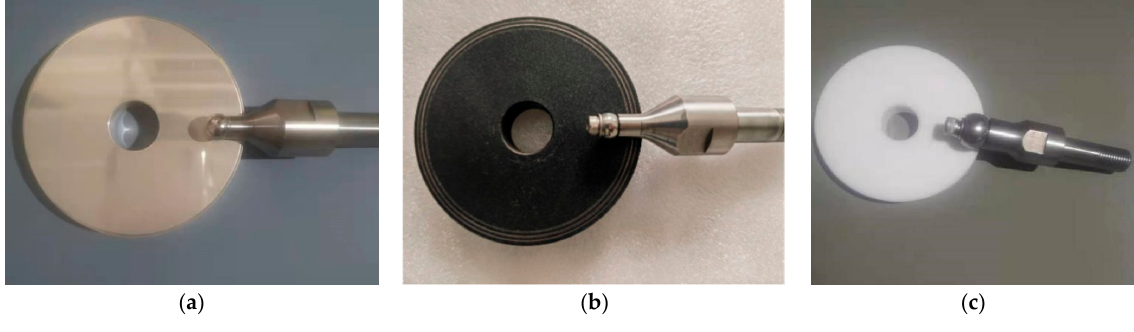
Figure 3. Ball-disc test specimens. ( a ) 440C-Ag-coated disk. ( b ) 440C-PTFE-coated disk. ( c ) 440C-solid PTFE disk. Table 1. The values of S m , K m , K ∞ under different contact interfaces.